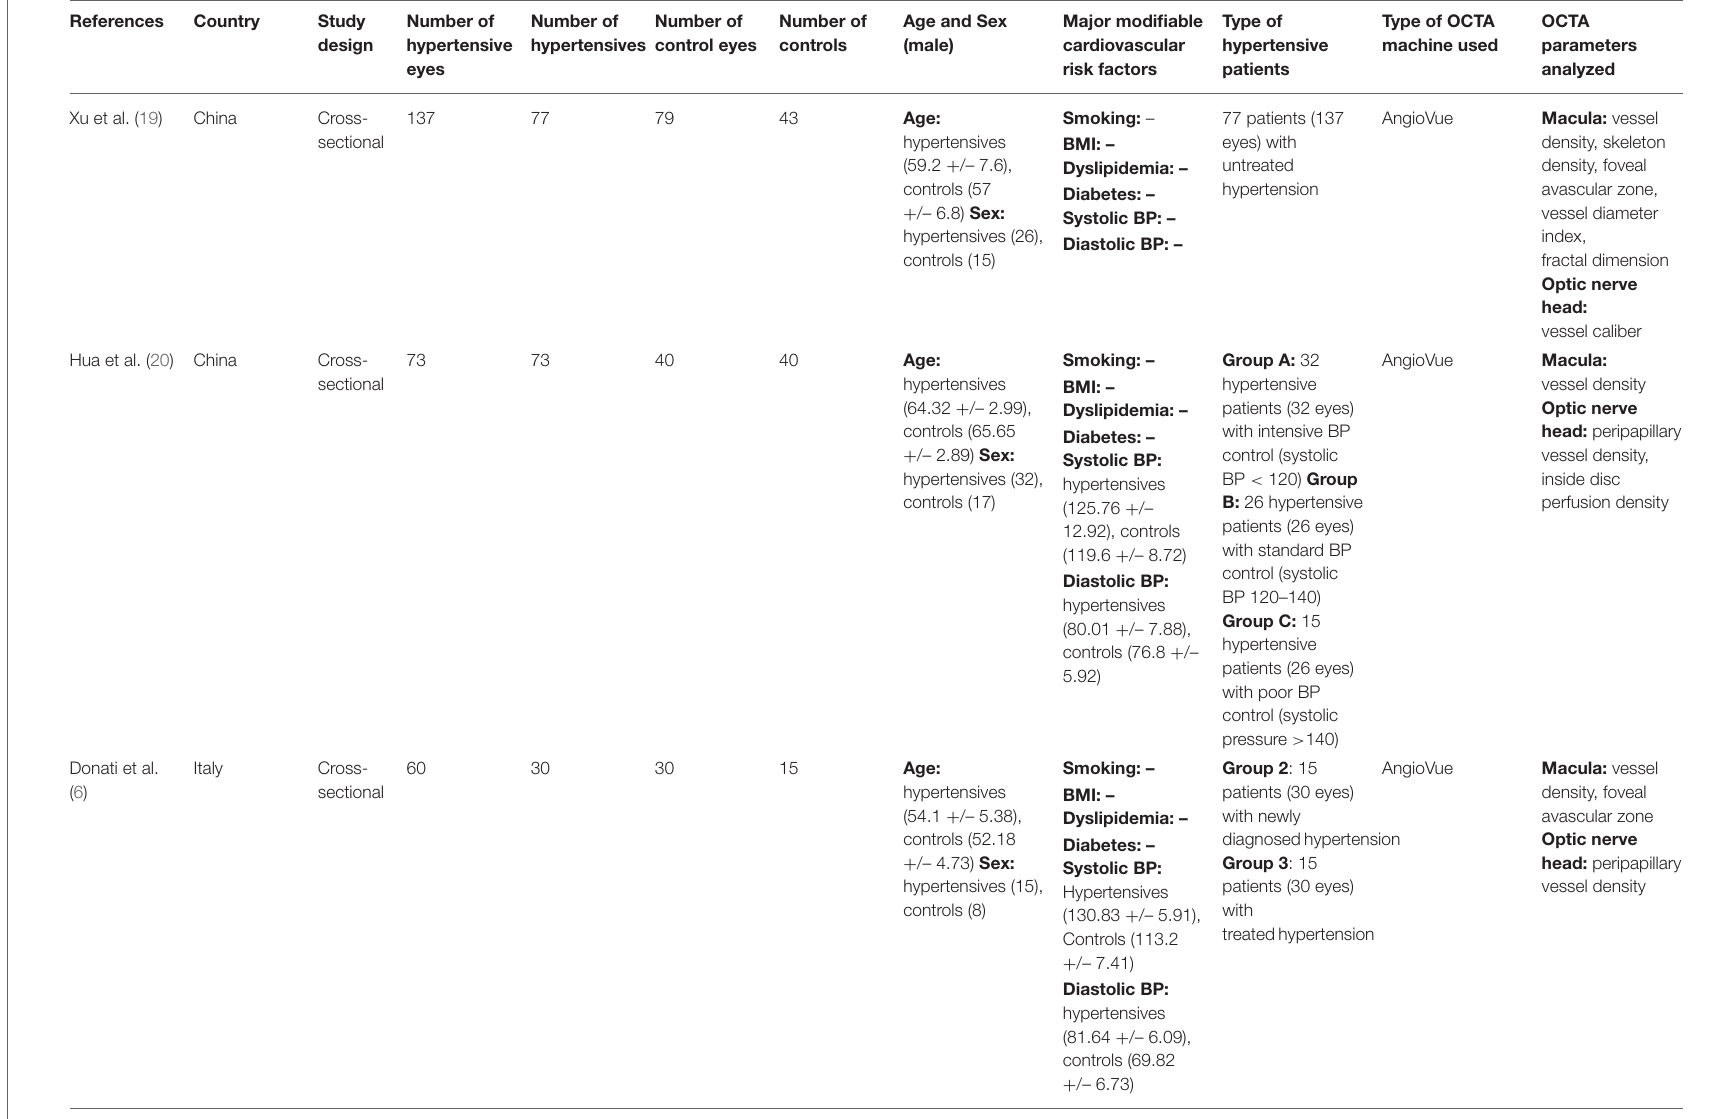
TABLE 1 | Key characteristics of the 11 eligible